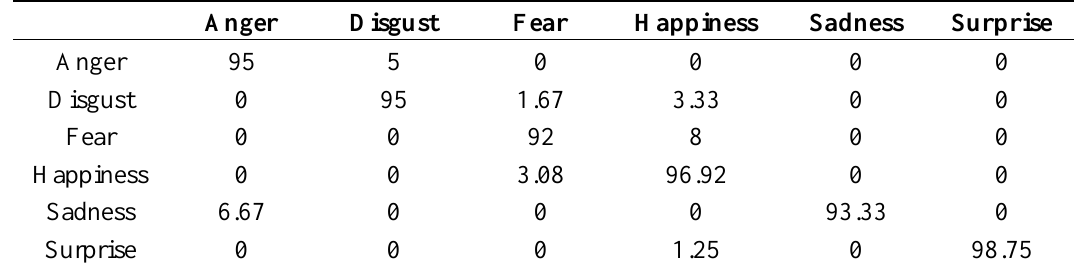
Table 3. Confusion matrix for facial expression recognition in percentages, using multi-class AdaBoost with 125 feature vectors.